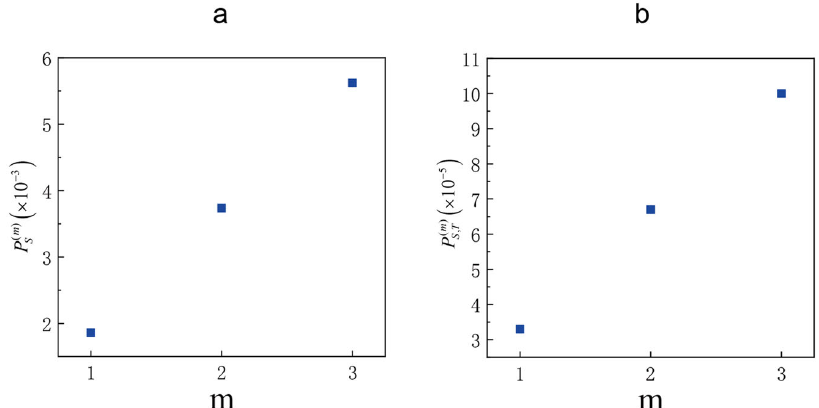
Fig. 4 Stokes detection probability and Stokes – anti-Stokes coincidence probability. a Blue squares are the measured values of Stokes detection probability P ð m Þ S as a function of the number of modes m. b Blue squares are the measured values of Stokes – anti-Stokes coincidence probability P ð m Þ S ; AS as a function of the number of modes m. The errors associated with the data correspond to one standard deviation of the measured value and are smaller than the data points